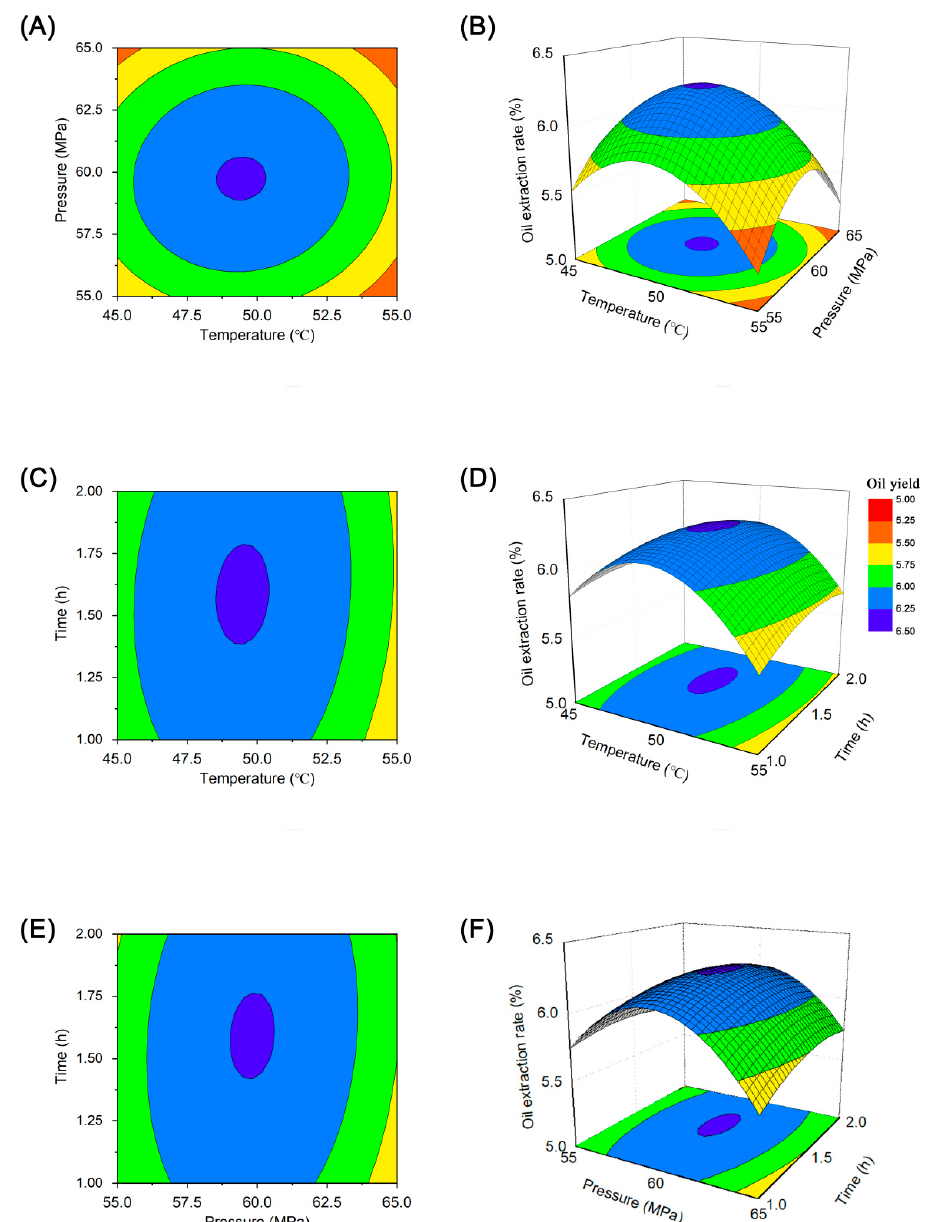
Figure 5. Two-dimensional contour plots ( A , C , D ) and surface three-dimensional diagrams ( B , D , F ) showing the interaction between temperature, pressure, and time on oil yield.